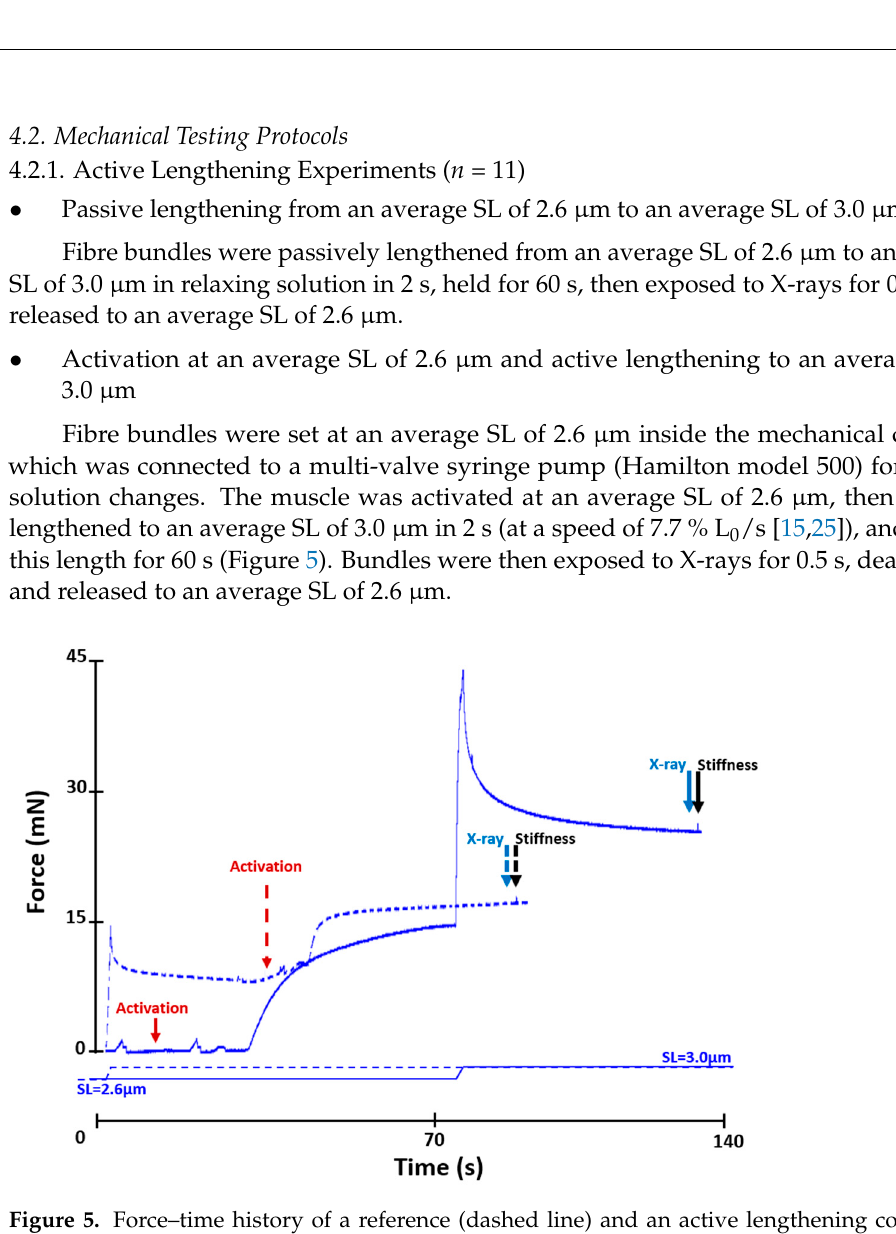
Figure 5. Force–time history of a reference (dashed line) and an active lengthening contraction (solid line). In the reference contraction, the fibre was passively lengthened from an average SL of 2.6 µ m to an average SL of 3.0 µ m and then activated. In the active lengthening contraction, the fibre was activated at an average SL of 2.6 µ m and then actively lengthened to an average SL of 3.0 µ m. Activation occurred when the relaxing solution in the testing chamber was replaced by a washing solution (free of EGTA and calcium) and then an activating solution (pCa 4.2). The noise in the graphs indicates the time when the solutions were changed. The dashed line arrows indicate events in the reference contraction, while the solid line arrows indicate events in the active lengthening contraction. The fibre was exposed to X-rays at steady-state isometric contraction following activation at a sarcomere length of 3.0 µ m in the reference condition, and following active lengthening from an average SL of 2.6 to 3.0 µ m in the active lengthening condition. Stiffness was measured after exposure to X-rays.